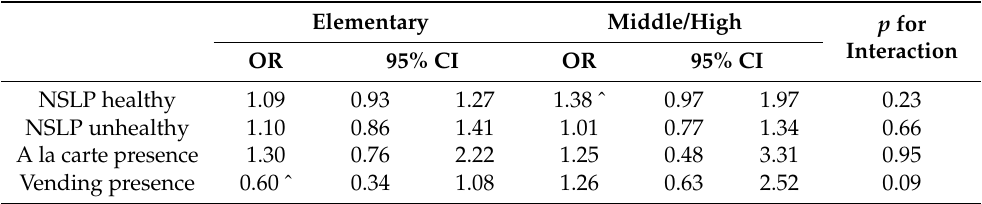
Table 4. Interaction between measures of the school food environment and parental perceptions by school level.